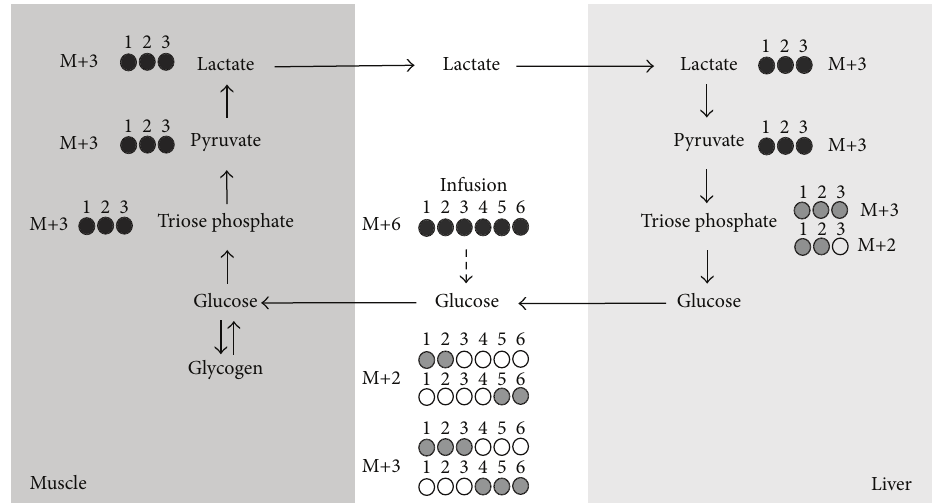
Figure 1: Schematic of plasma glucose 13 C-isotopomer formation following infusion of [U- 13 C 6 ]glucose (represented by black closed circles), its initial conversion to [1,2,3- 13 C 3 ]pyruvate and lactate via glycolysis, and gluconeogenic conversion of this isotopomer to form M+2 and M+3 glucose isotopomers (shown in